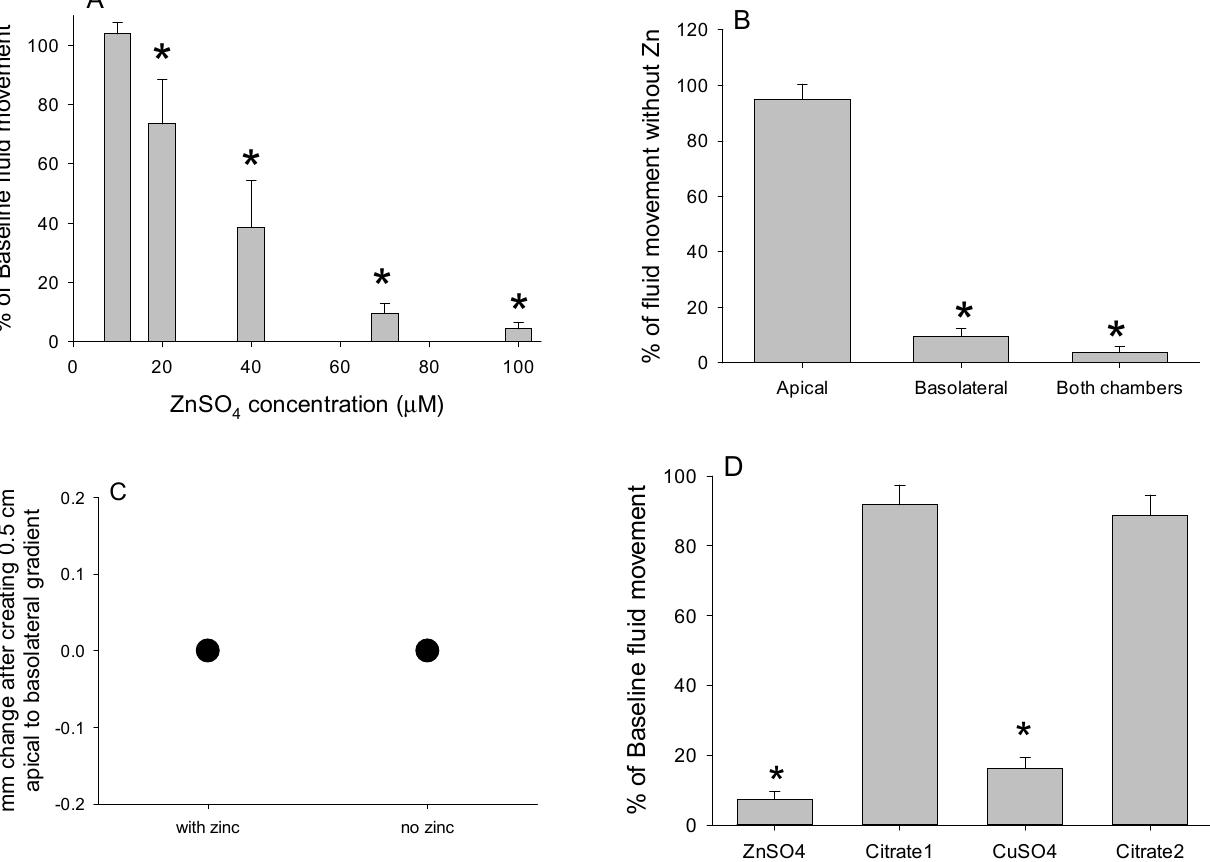
Figure 11. ( A ) Enterocytes harvested from 2 mice and cultured on inserts with 12 µ m pores ( n = 12 per mouse) were exposed to concentrations of zinc sulfate in both chambers ranging from 0 to 100 µ M ( n = 2 per concentration for each mouse). Values are expressed as the percentages of baseline flow prior to the addition of zinc (100%) and asterisks indicate a significant decline was detected ( p < 0.05). ( B ) Enterocytes from 2 mice were cultured on inserts with 12 µ m pores ( n = 6 per mouse) and exposed to zinc sulfate (100 µ M) only in the apical or the basolateral chamber, or in both chamber ( n = 2 per condition for inserts prepared from each mouse). Values are the percentages of fluid flow prior to the addition of zinc and asterisks indicate a significant decline was detected ( p < 0.05). ( C ) A basolateral-directed hydrostatic pressure gradient of 0.5 cm did not dissipate over a 15 min period in the presence or absence of zinc in both chambers (100 µ M). ( D ) Enterocytes from two mice were cultured on inserts with 12 µ m pores and exposed to vigorous aeration before adding either zinc or copper (100 µ M) to inhibit fluid flow ( n = 4 inserts per inhibitor per mouse) and then to citrate (50 µ M), which restored fluid flow. Values are expressed as the percentage of the initial fluid flow that was significantly reduced by the addition of zinc sulfate or copper sulfate (*) and the subsequent recovery to near initial rates after the addition of sodium